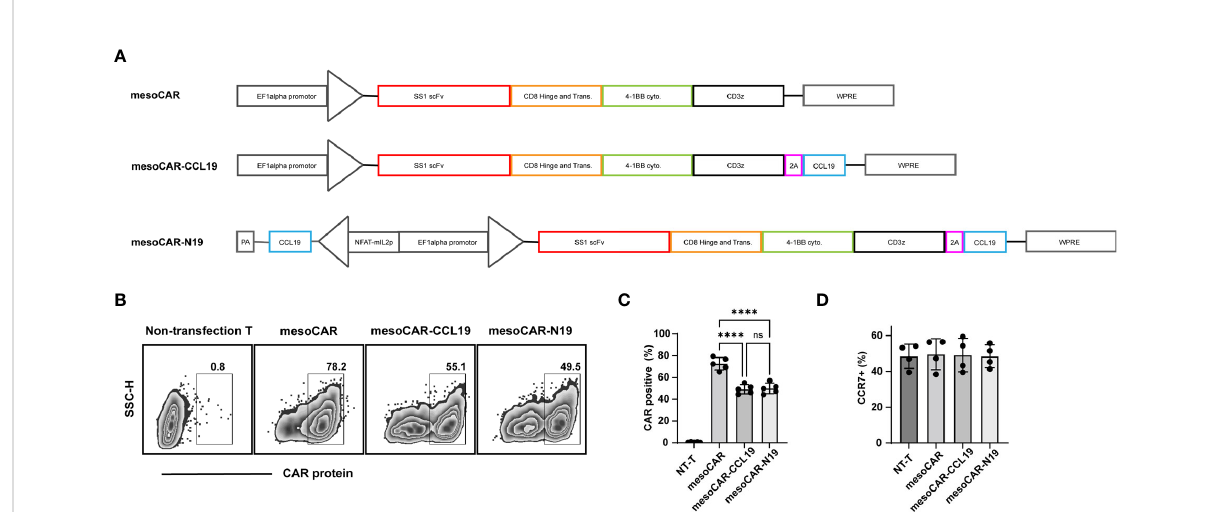
FIGURE 1 Characterization of chimeric antigen receptor T (CAR-T) cells: (A) Schematic diagram of the CAR structure; (B) Detection of CAR protein transfection ef fi ciency by fl ow cytometry and (C) statistics performed on fi ve donor-derived cells; (D) Detection of C-C motif chemokine receptor 7 positivity by fl ow cytometry. Error bars represent the mean ± standard deviation (n = 5). ****P<0.0001. ns, no signi fi